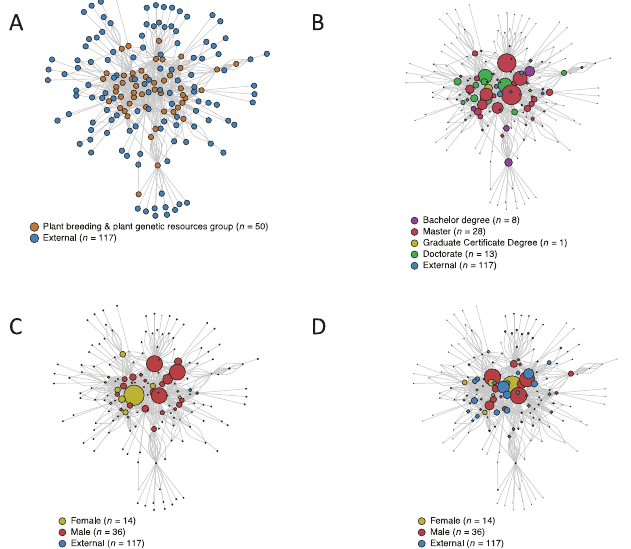
Figure 9. Graphical representation of the network analysis of 50 researchers working in plant breeding and plant genetic resources in A GROSAVIA and 117 externals (including researchers from other disciplines within A GROSAVIA and outside institutions). ( A ) Distribution of researchers (nodes) and their interactions (edges) separating the 50 researchers from the PB&PGR group and the 117 externals. ( B ) Characterization of researchers (nodes) by the degree score (i.e., size of the circle) and highest academic degree (i.e., color). The degree score indicates the number of adjacent direct interactions with other researchers. ( C ) Characterization of researchers (nodes) by the hub score (i.e., size of the circle) and gender (i.e., color). The hub score measures the ability of a researcher to make a relation with other influential researchers (i.e., author- ities). ( D ) Characterization of researchers (nodes) by the authorities score (i.e., size of the circle) and gender (color). The authority score indicates the number of links of interactions that a researcher earned. Therefore, authority researchers should have relevant information on the field and receive more links from other